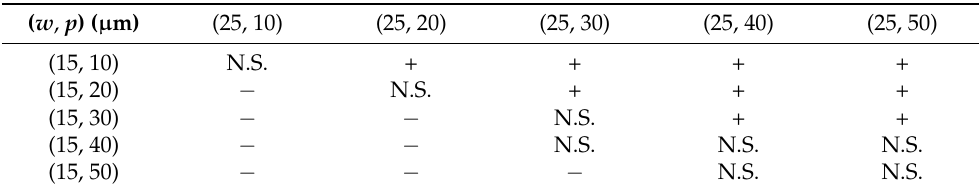
Table 2. Statistical significance in dryness perception between samples with  values of 15 and 25 µm.